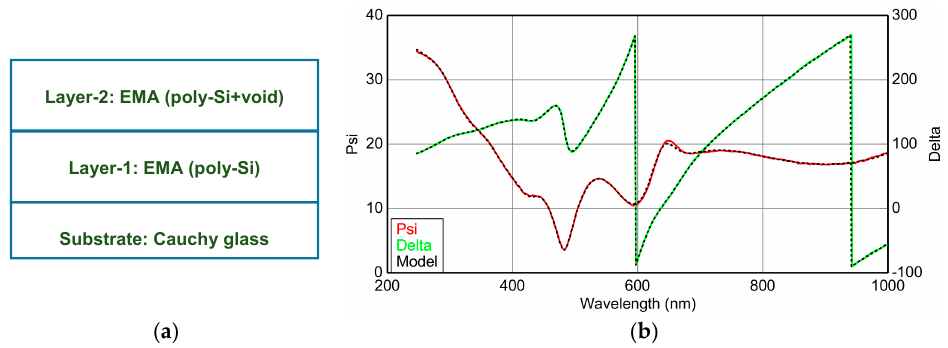
Figure 4. SE results for flash lamp annealed Si film: Optical model used for fitting SE data ( a ) and experimental (solid) and fitted (dotted) plot for psi and delta vs. wavelength ( b ).